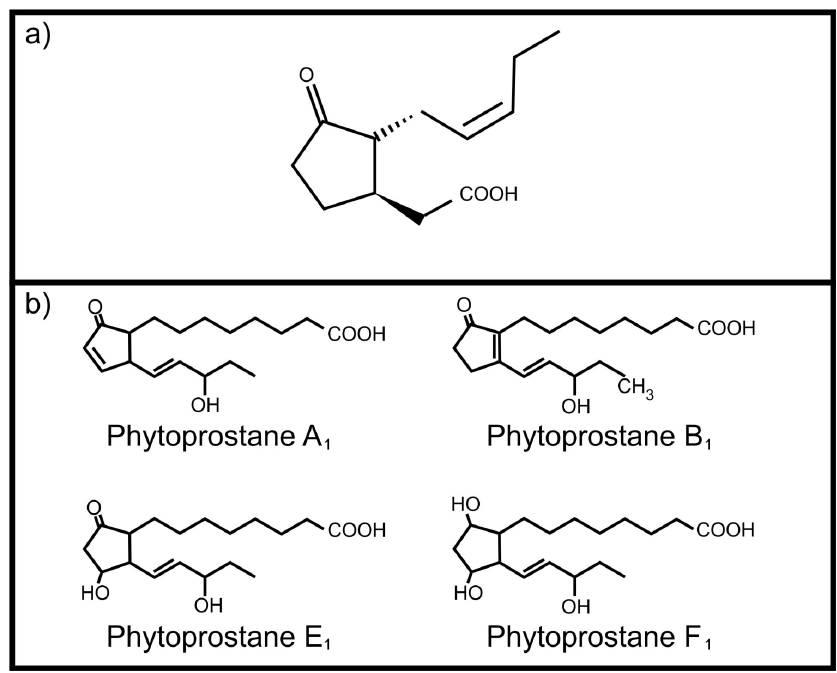
Figure 1. Plant oxylipins involved in communication with animals ( a ) Jasmonic acid; ( b ) Phytoprostanes.